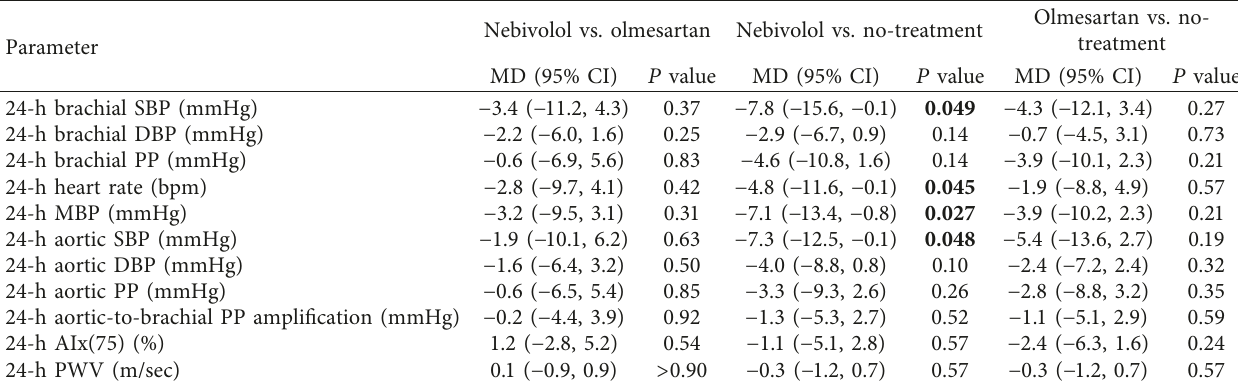
Table 3: Between-group differences in change from baseline to study-end of peripheral and central hemodynamic parameters.